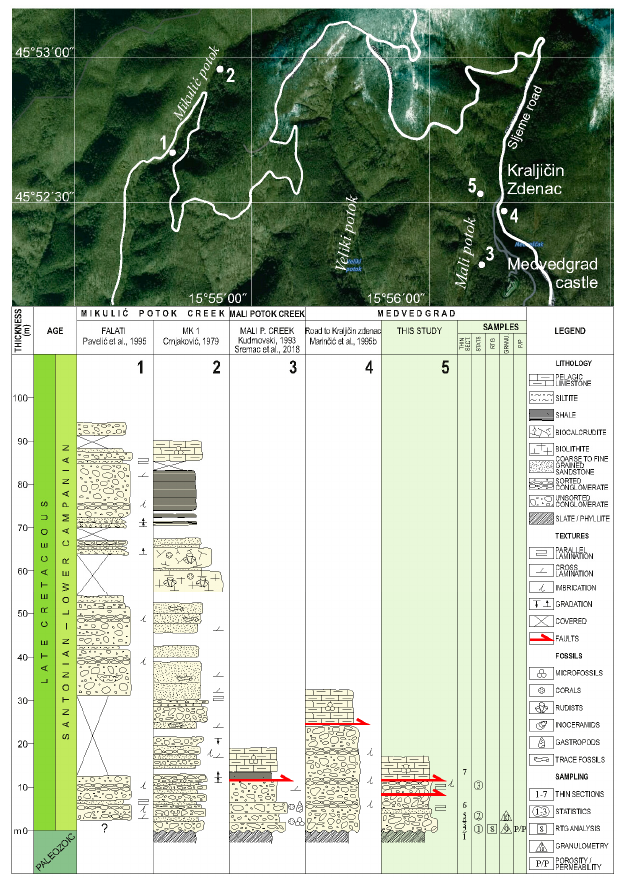
Figure 2. Location map of conglomerate outcrops in the south-western part of the Medvednica Mt. (1–5) and sedimentary logs of Upper Cretaceous clastic-carbonate successions, with position of sampling points (after [4,7,8,10,30], this study).